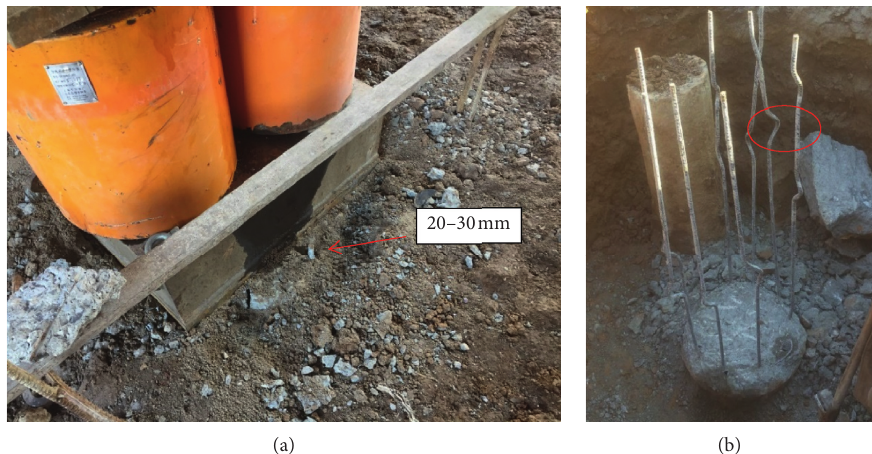
Figure 6: (a) Concrete crack from pile head. (b) Bent reinforcement.